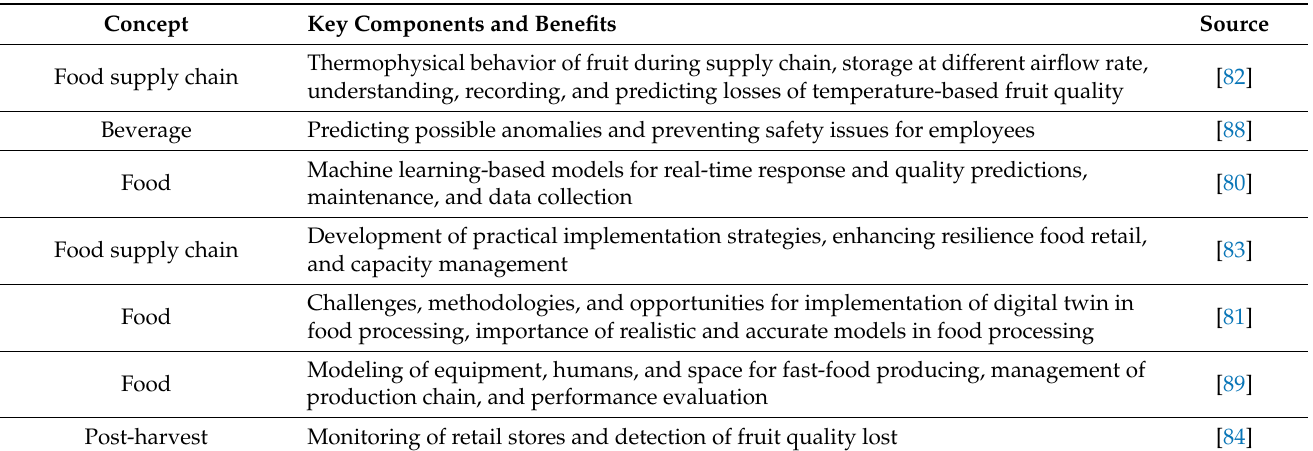
Table 4. Summary of digital twin for post-harvest